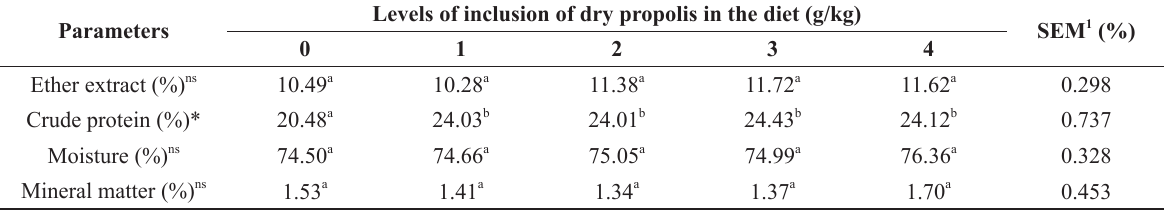
Body chemical composition of Nile tilapia fingerlings fed with increasing levels of inclusion of propolis extract in the diet. Levels of inclusion of dry propolis in the diet (g/kg) Parameters